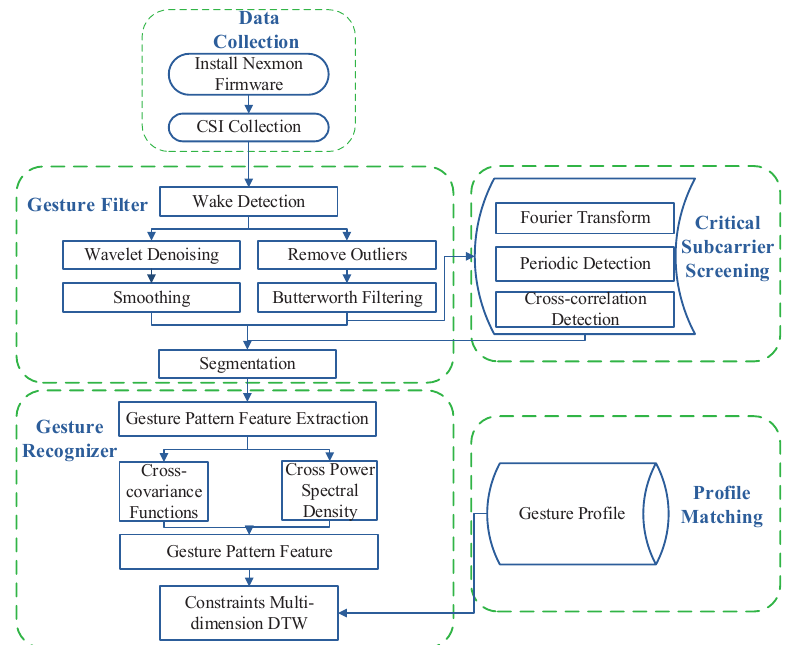
Figure 1. MDGest